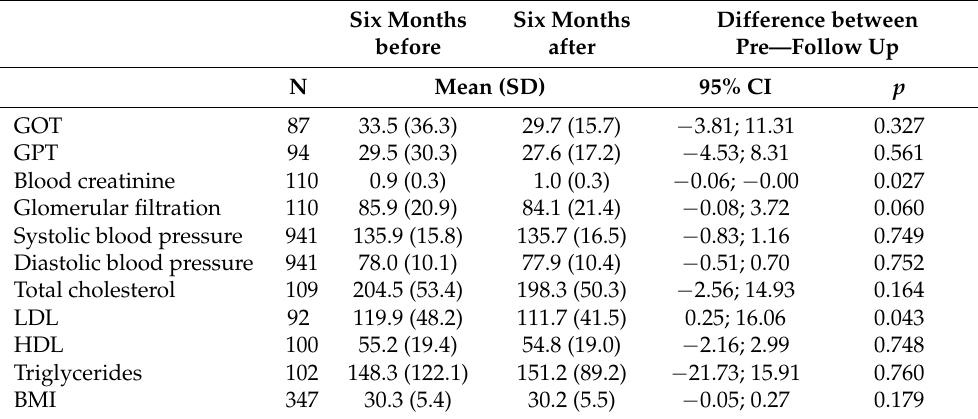
Table 2. Changes in the clinical parameters of alcohol abuse disorder patients before and after lockdown.